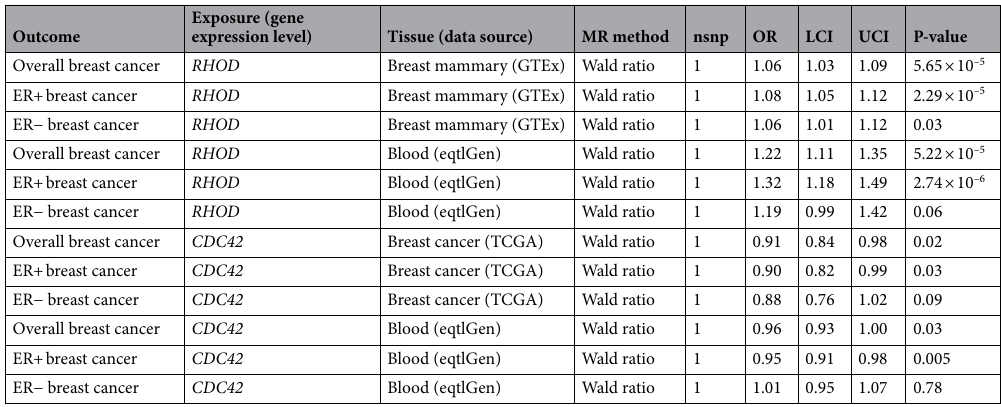
Table 2. Mendelian randomisation analyses of the association of RHOD and CDC42 with overall, ER+ and ER− breast cancer risk. nsnp number of SNPs used in the analysis, OR odds ratio, LCI 95% lower confidence interval, UCI 95% upper confidence interval, P-value P-value for